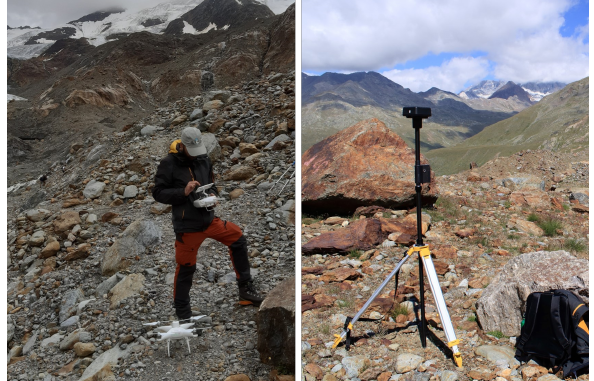
Figure 1. DJI Phantom 4 RTK and D-RTK 2 high precision GNSS mobile